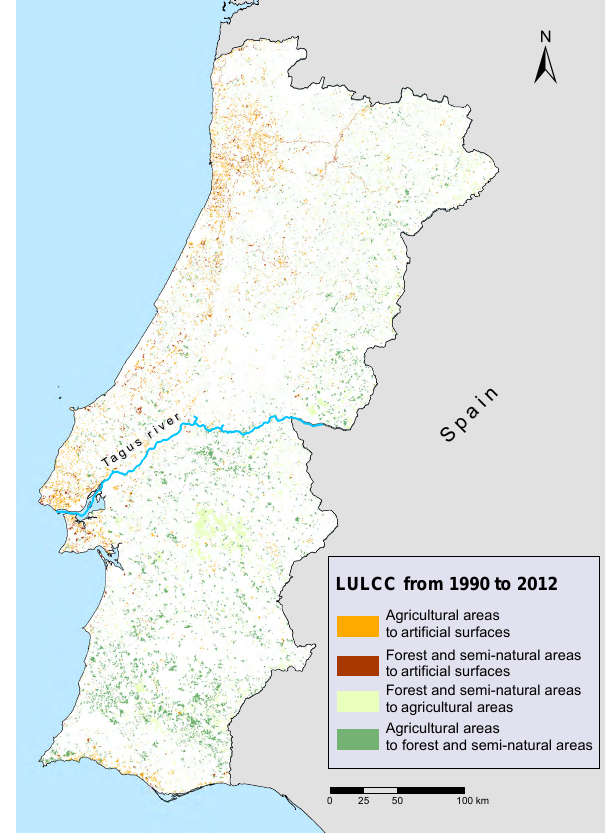
Figure 3. Map of land cover/land use transition from 1990 to 2012, evaluated considering the first-level hierarchy of CLC 1990 and CLC